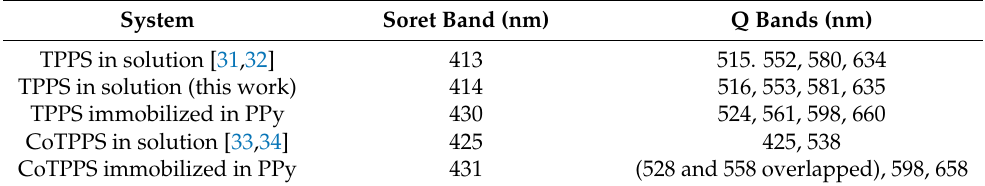
Figure 6. UV-Vis characterization of PPy-ClO 4 , PPy-L and PPy-C before ( A ) and after ( B ) the photoelectrochemical test under anodic conditions (light chopped chronoamperometry at 0.6 V in 0.1 M Na 2 S 2 O 3 ). Table 1. Absorption bands of TPPS and meso-tetra-(4-sulfonatophenyl)-porphyrinato cobalt (II)